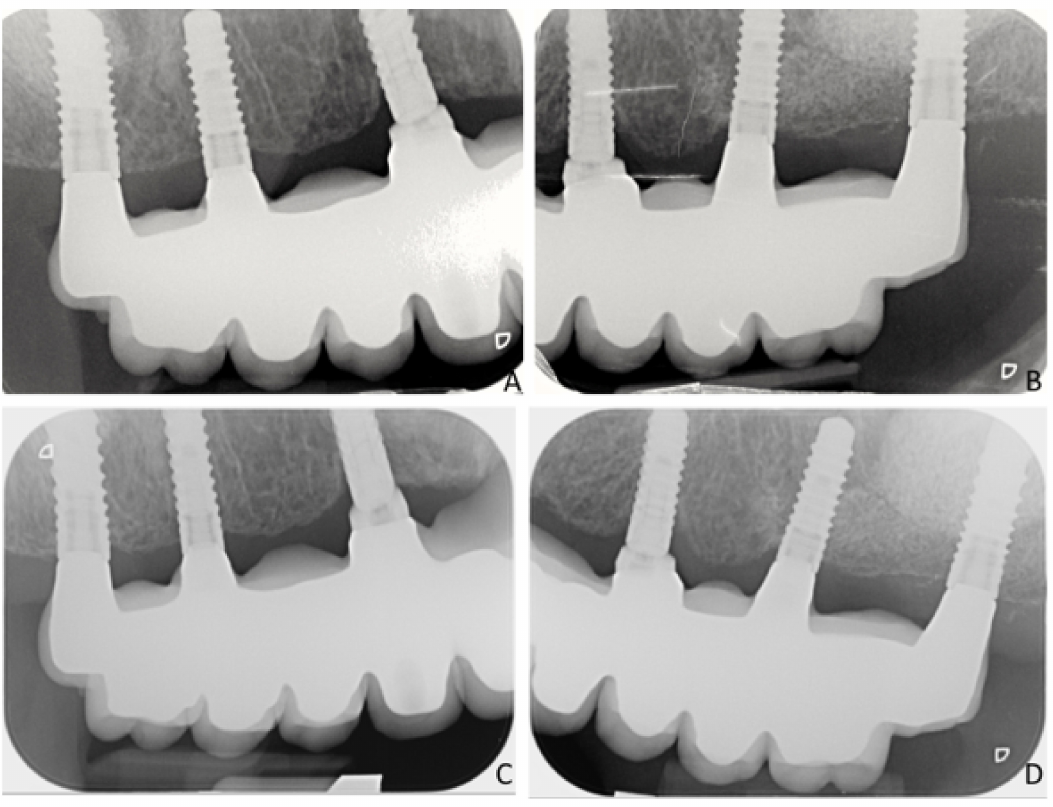
Figure 5. X-rays illustrating the situation of the control implant group immediately after loading ( A , B ), and after 24 months of loading ( C , D ).